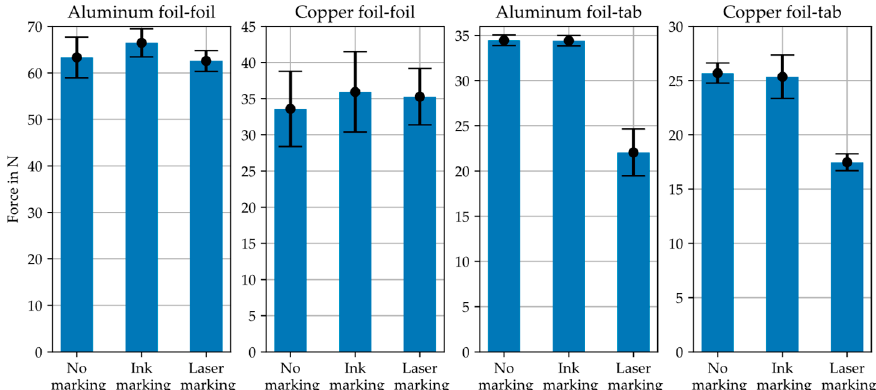
Figure 12. Averaged measured force and standard deviation of foil–foil and foil–tab tests without marking, with ink marking, and with laser marking for aluminum and copper foils.